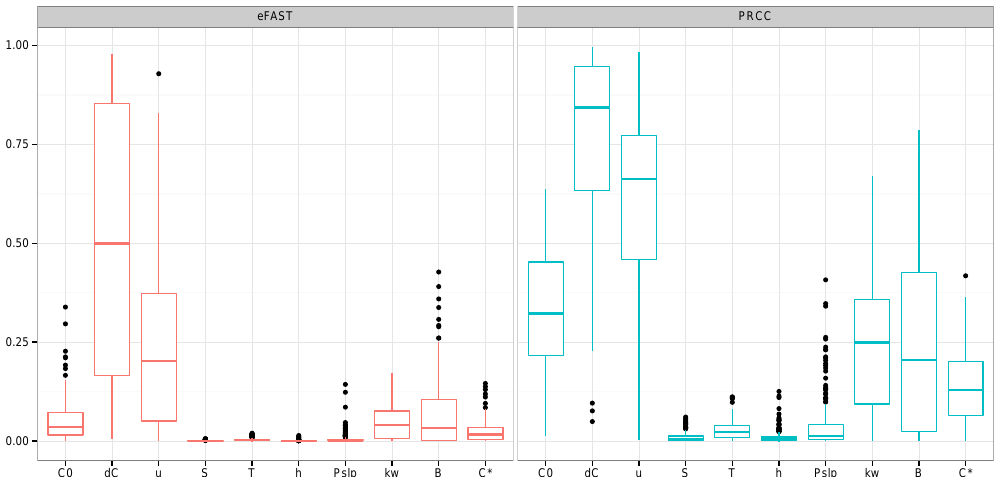
Figure 7. Warp sensitivity analysis indices. (a) eFAST total-order Sobol indices (fractional uncertainty contributions). (b) PRCC squared indices (ranked uncertainty contributions). Box plot upper and lower hinges correspond to first and third quartiles; whiskers extend to 1 . 5 × of the inter-quartile range; outliers are marked with dots. See Table 2 for variable definitions.